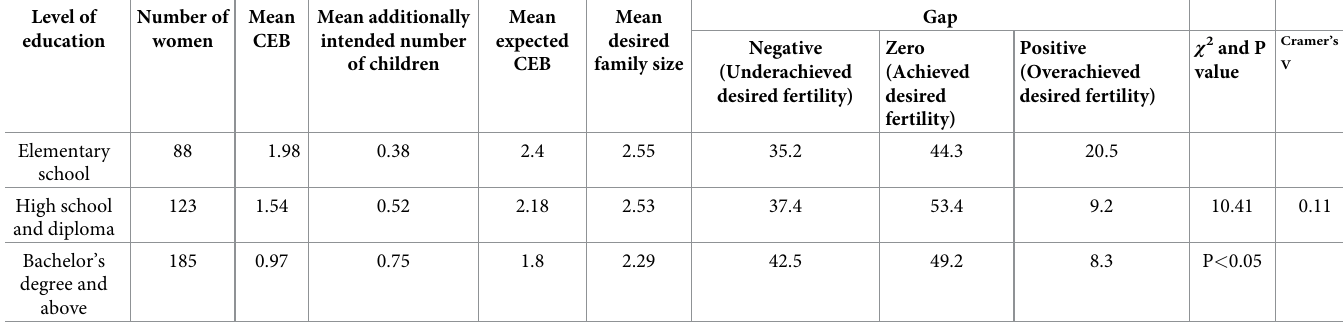
Table 5. Mean number of children ever born (CEB), mean expected CEB, mean desired family size and the gap between mean CEB and mean expected CEB by women’s level of